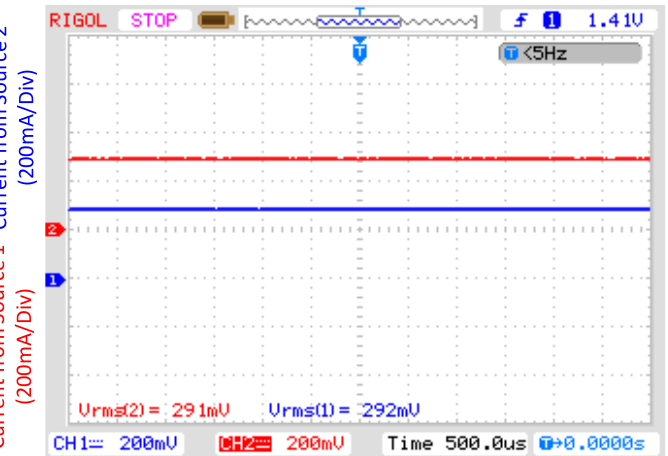
Figure 8. Current sharing of two sources in micro-grid operation using the purposed